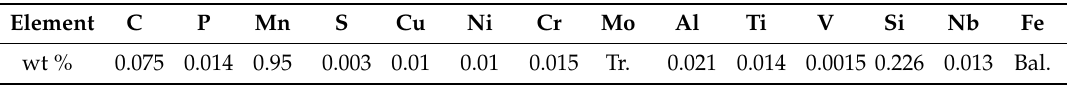
Table 1. Measured chemical composition (wt %) for the X52 pipeline